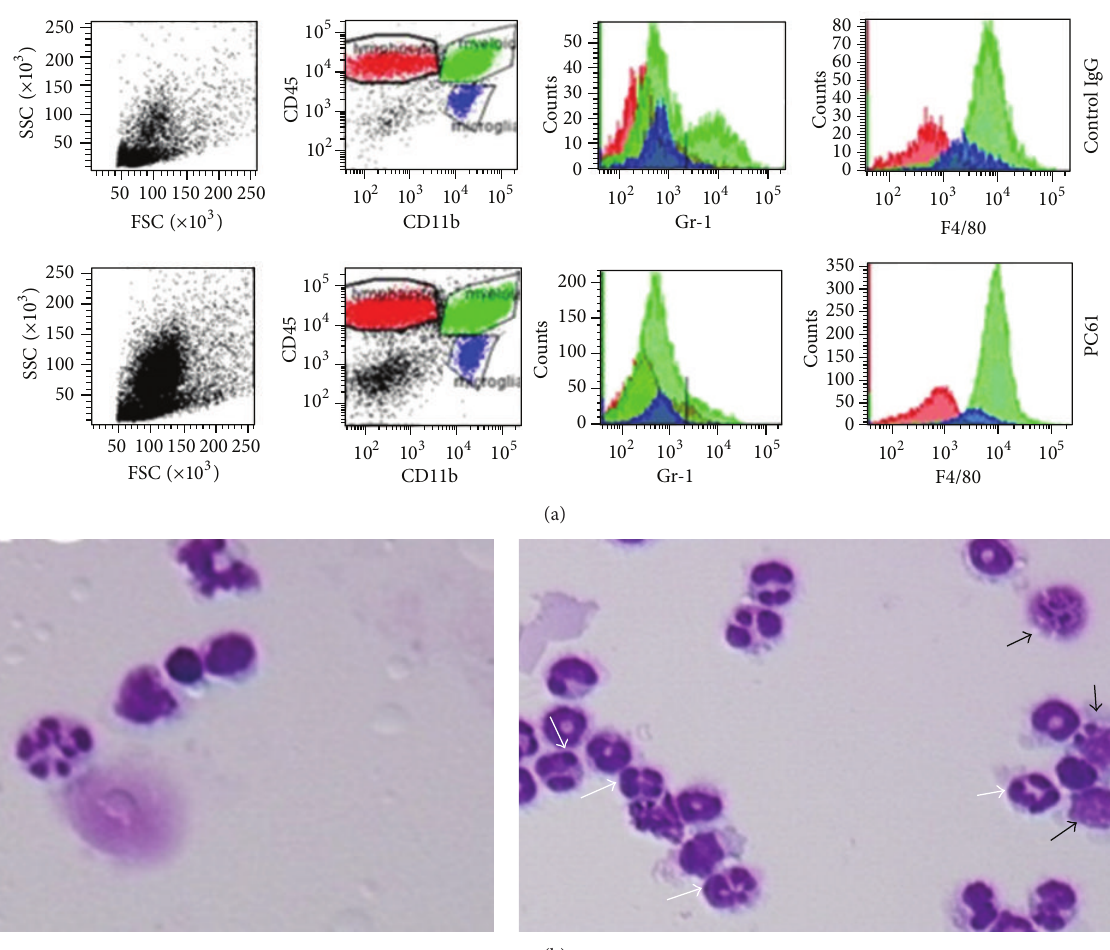
Figure 2: PC61 treatment of glioma-bearing mice leads to local infiltration with macrophages and granulocytes. (a) Flowcytometric phenotyping of brain-infiltrating myeloid cells in control (upper row) and PC61-treated mice (lower row). Based on the expression of CD45 and CD11b, three populations of brain-infiltrating cells were identified: CD45+CD11b − lymphocytes (in red), CD45+CD11b+ myeloid cells (in green), and CD45-CD11b+ microglial cells (in blue). Within the CD45+CD11b+ myeloid cells, expression of Ly6G (Gr-1) and F4/80 was measured. (b) Morphologic analysis of brain-infiltrating myeloid cells on cytospins. Detail from a representative FOV (40x) from control IgG- treated mice (left) and mice that were PC61 treated (right). Macrophages (black arrows) and granulocytes (white arrows) are